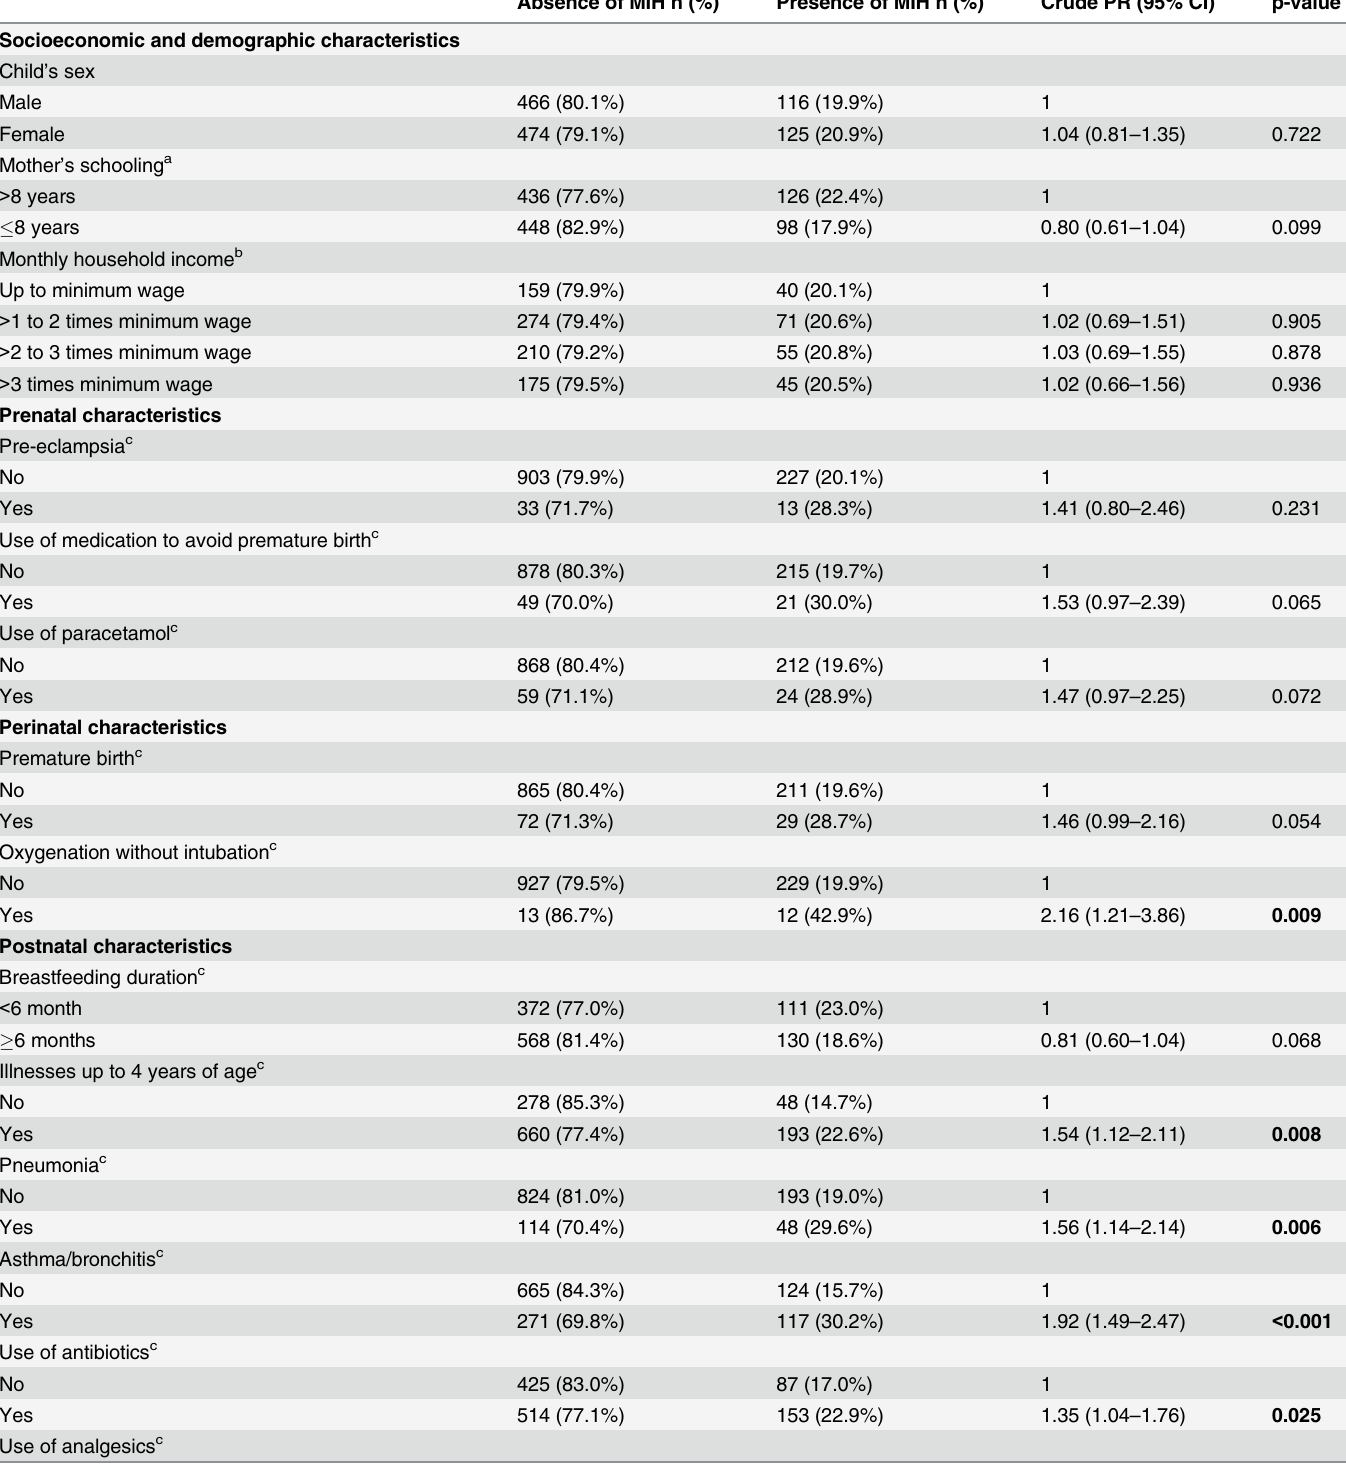
Table 1. Frequency distribution of MIH and crude prevalence ratio according to socioeconomic, demographic, prenatal, perinatal, postnatal and oral health characteristics (n =